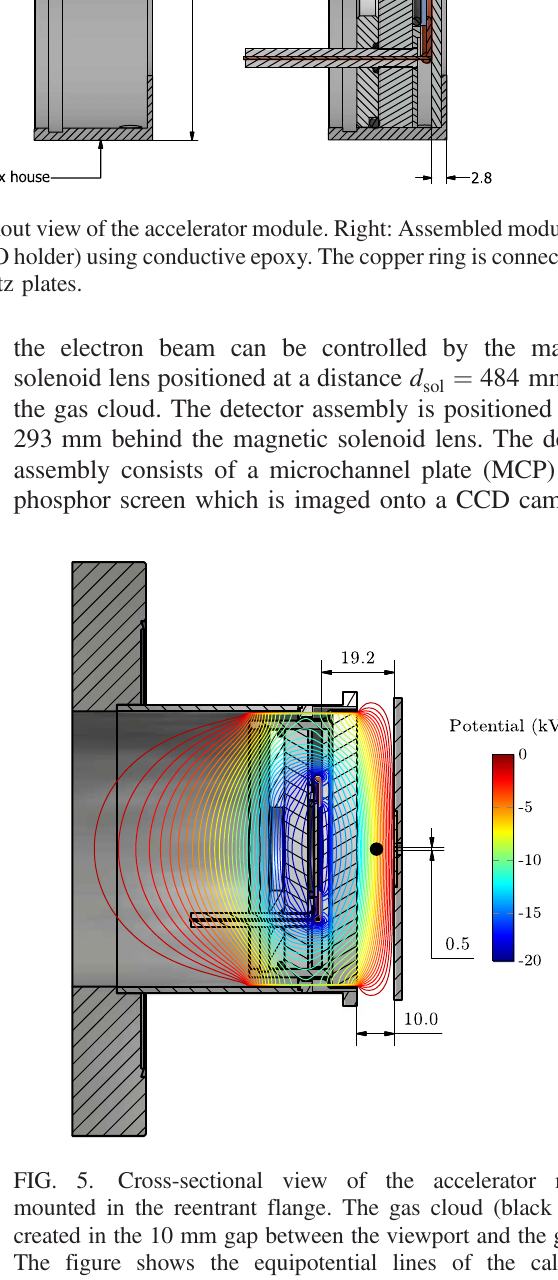
FIG. 5. Cross-sectional view of the accelerator module mounted in the reentrant flange. The gas cloud (black dot) is created in the 10 mm gap between the viewport and the grating. The figure shows the equipotential lines of the calculated electrostatic field generated by the transparent electrode. The ¼ − 20 kV and is separated 19.2 mm from the electrode is at V acc grounded grating holder. The hole in the grating has a diameter of 0.5